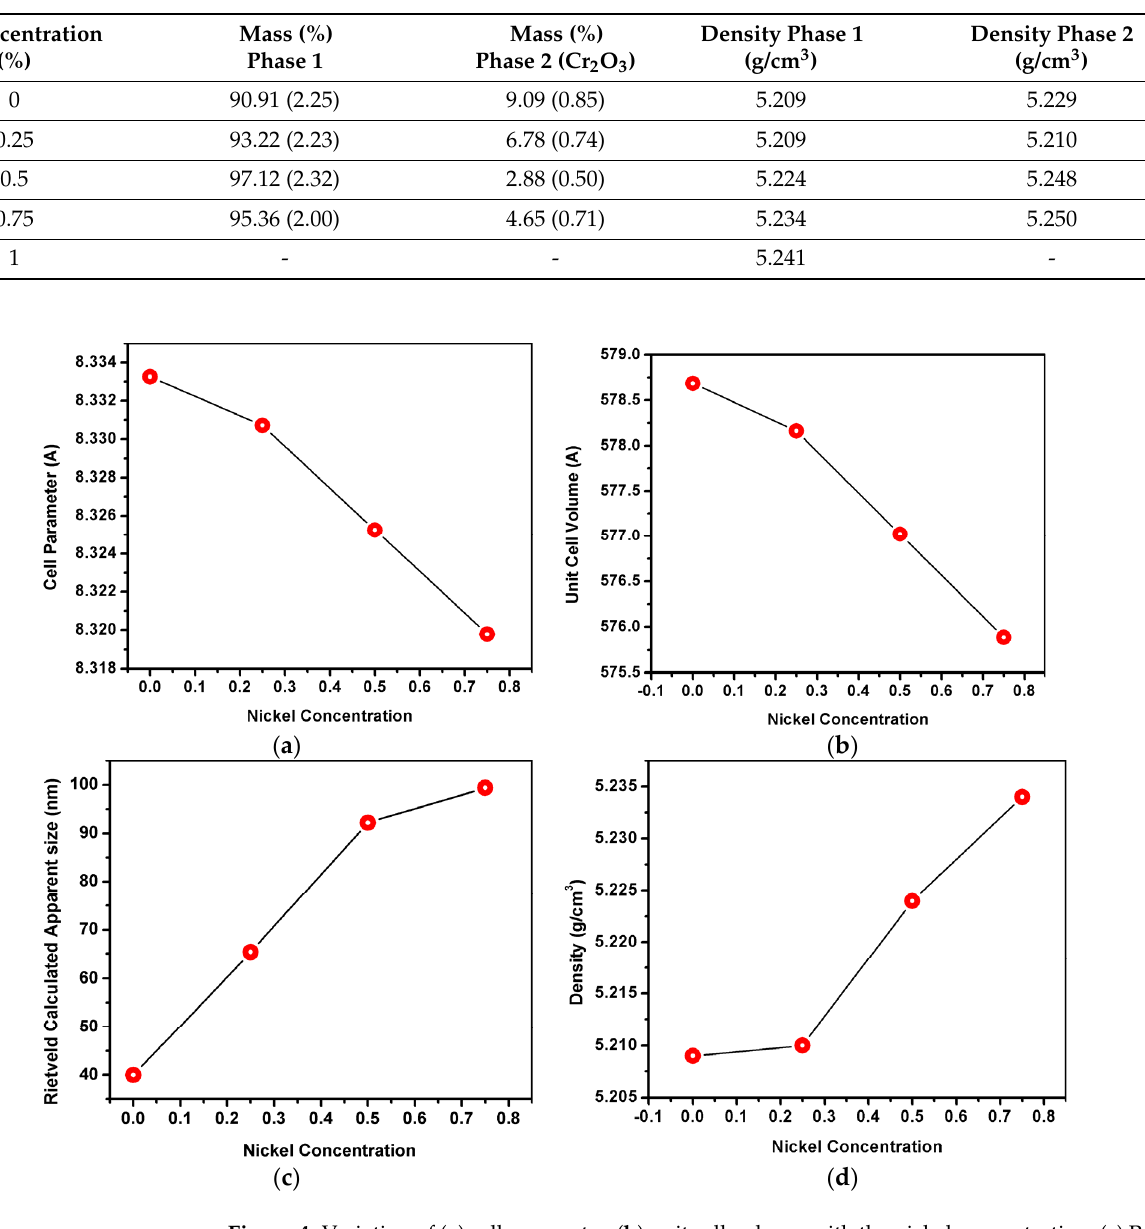
Figure 4. Variation of ( a ) cell parameter, ( b ) unit cell volume with the nickel concentration, ( c ) Rietveld Calculated Apparent size and density ( d ). Table 1. Calculated crystallographic parameters.